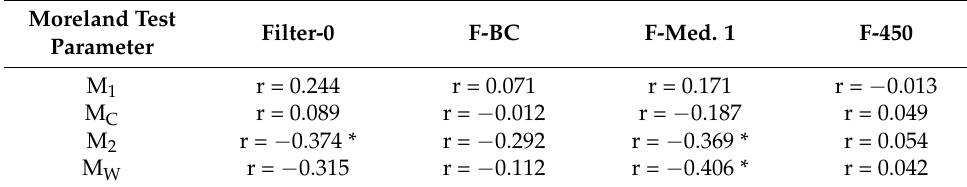
Table 3. Comparison of Spearman’s rank correlation coefficient (r) for a M vs. other Moreland test parameters. The correlations were weak or none, which means that the aspect of perceived color brightness is essentially different from the general ability to perceive the blue and green